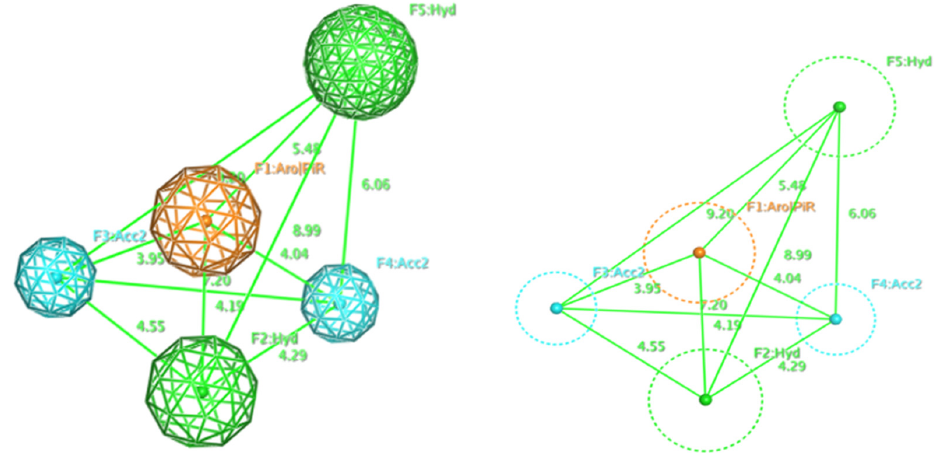
Figure 4. Factors of five-point pharmacophore model. F3, F4 ( the blue ): hydrogen bonding acceptors (Acc2); F2, F5 ( the green ): hydrophobic groups (Hyd); F1 ( the orange ): an aromatic ring or π conjugated ring (Aro|PiR).